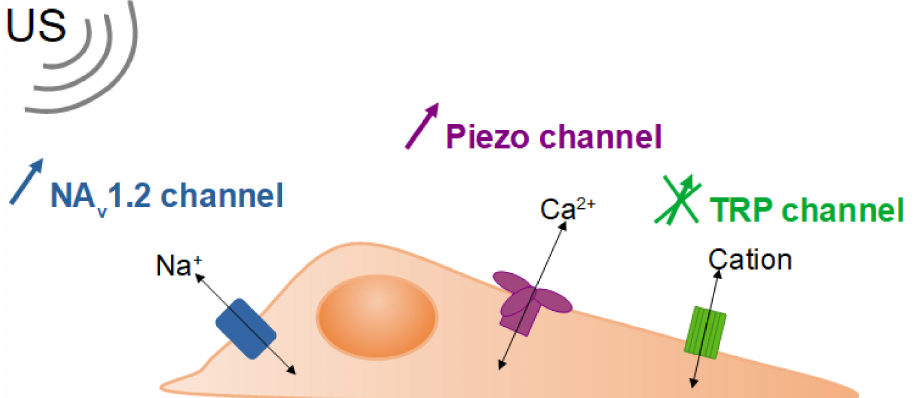
Figure 5. Schematic description of cellular ionic channels: Na v 1.2 and piezo channels were shown to be activated by SAW, while no significant impact on TRP (transient receptor potential) channel was